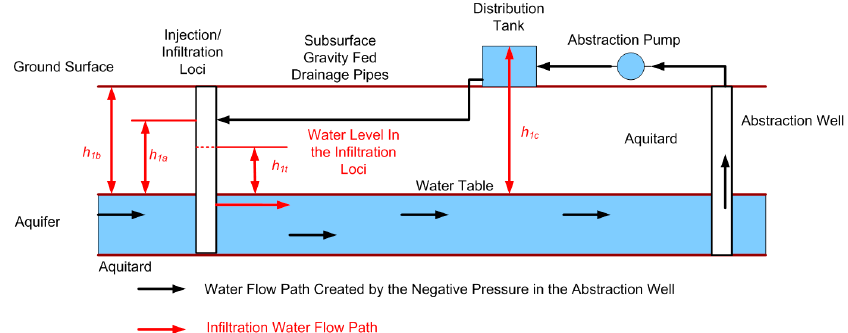
Figure 22. Cross section of a schematic Aquifer Treatment Zone showing gravity feed water recycle. The maximum head is controlled by the water level in the distribution tank, h 1c . The subsurface pipe enters the infiltration device at a height, h 1a , above the water table. The water level can rise in the infiltration device to the ground surface (height h 1b ). If the water level rises above height h 1b , the